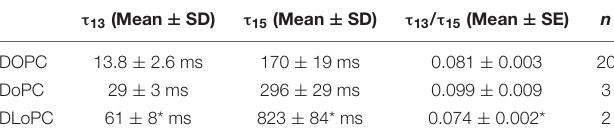
TABLE 3 | gA channel lifetimes in bilayers formed by DOPC, DoPC, and